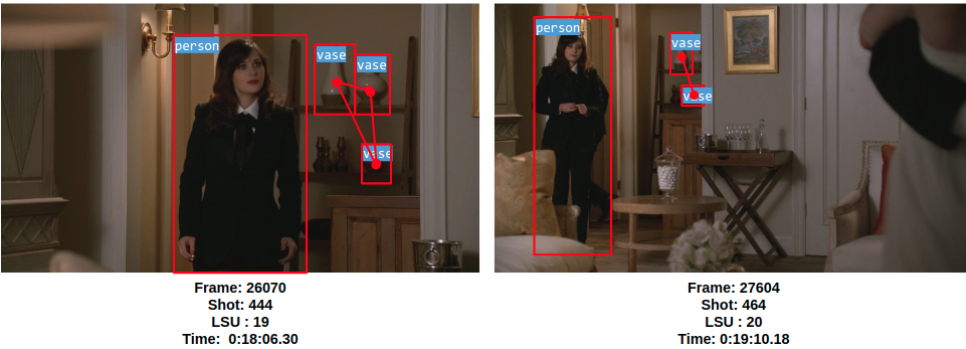
Figure 8. Example of multiple instance object class. This example is taken from the Season 4 Episode 16 of New Girl TV SOAP show. In the left side image (frame 26070) there are three different objects of the class ( vase ) detected, while in the right image (frame 27604), there are two objects of this class